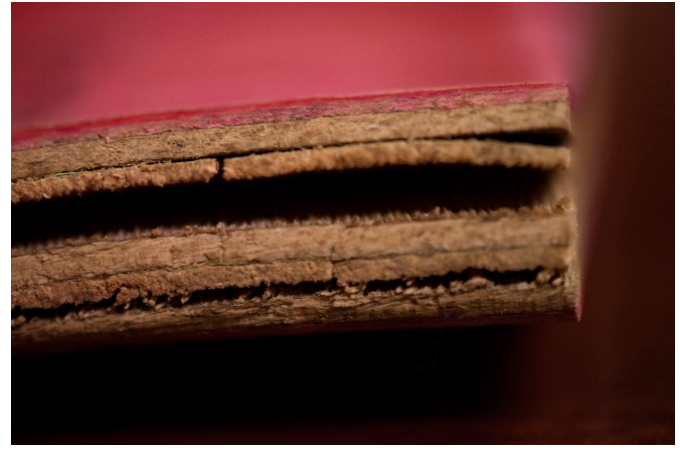
Figure 14. Face wise close up view of sample 2 showing delamination after soak/dry moisture durability test (ANSI/HVPA EF 2009 [4]).